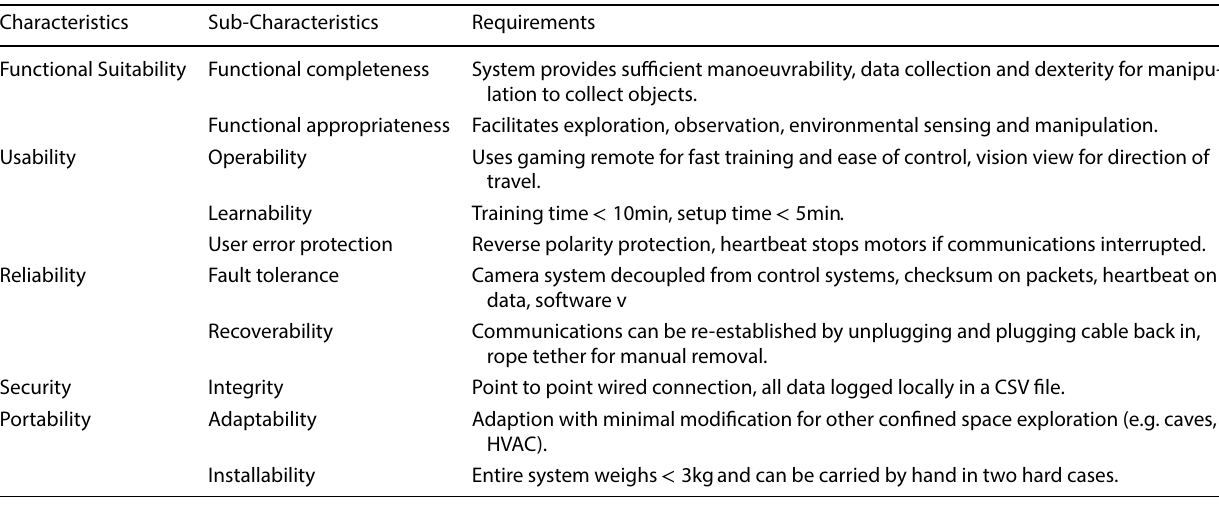
Fig. 2 WomBot system block diagram